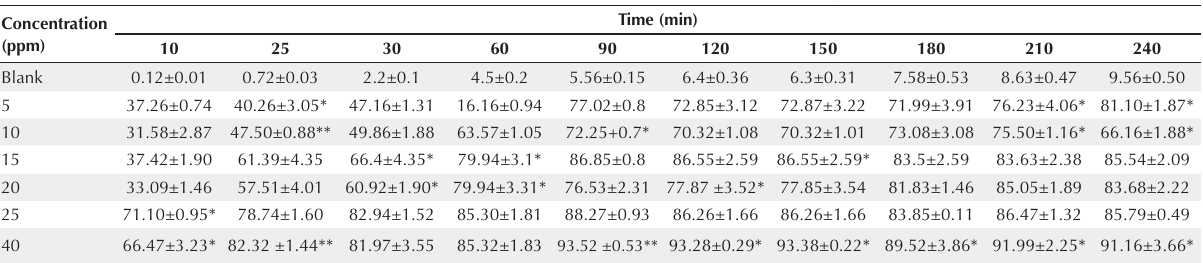
-N-S photocatalyst under sunlight 2